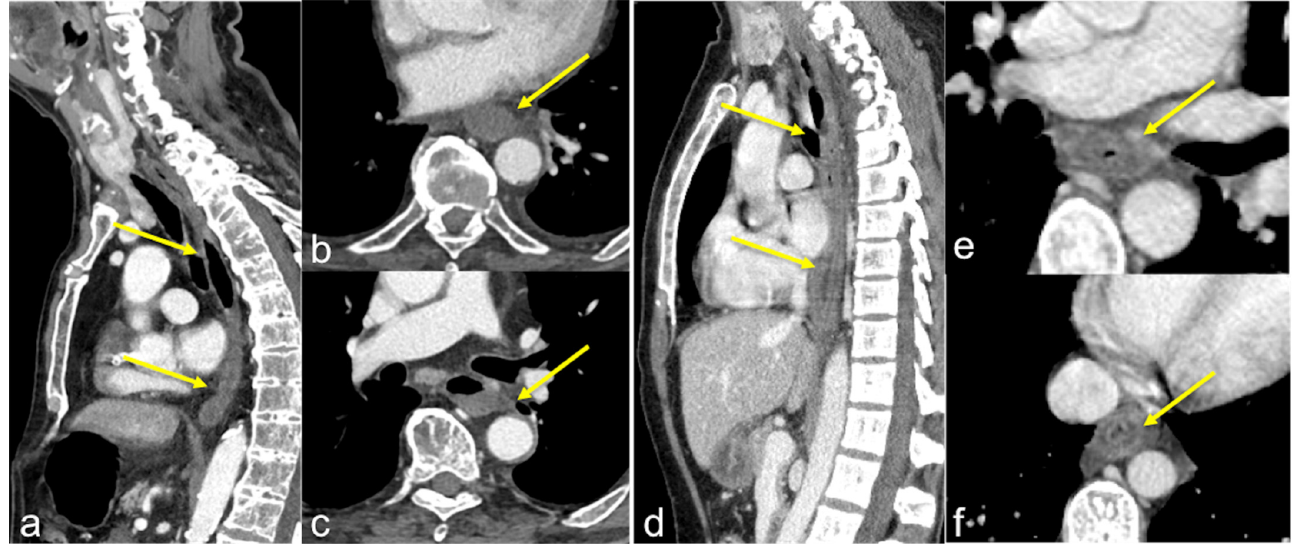
Figure 23. Two different patients with consequences of caustic ingestion on the oesophagus. En- hanced CTA scan in the portal venous phase in sagittal ( a , d ) and axial ( b , c , e , f ) views. Note, in the first case ( a – c ) the extensive oesophageal necrosis (( a – c ) arrows) with a thin and unenhanced wall, in the second case ( d – f ) the oesophageal thickening with a stratified wall (( d – f ) arrows).